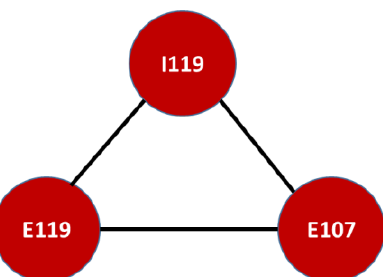
Figure 9. Clique with the highest overlap in morbidity and mortality networks. Mortality Network of Diseases for the victims of the armed conflict in Colombia, resident in the Risaralda province, from 2011 to 2016. Source: authors’ own calculations. Note that the ICD-X codes correspond to: E119: type 2 diabetes mellitus without complications, I119: hypertensive heart disease without heart failure, and E107: diabetes mellitus insulin dependent, with multiple complications.